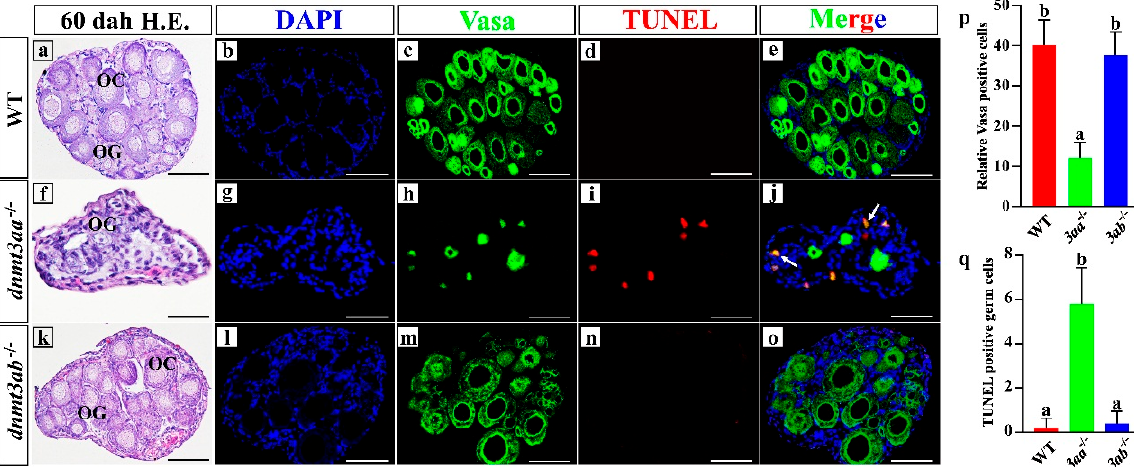
Figure 5. Apoptosis detection in WT, dnmt3aa − / − and dnmt3ab − / − ovaries at 60 dah. Increased apoptosis of germ cells in the ovaries of dnmt3aa − / − fish at 60 dah. ( a , f , k ) Histological analyses of germ cells by H&E staining. ( b , g , l ) Nuclei were coun- terstained with DAPI. ( c , h , m ) Green fluorescence represents the Vasa signals. ( d , i , n ) Red fluorescence represents the TUNEL-positive signals. ( e , j , o ) Co-localization of some Vasa and TUNEL signals as indicated by orange color in Nile tilapia ovaries. ( p ) Germ cell count of WT, dnmt3aa − / − and dnmt3ab − / − ovaries at 60 dah. ( q ) TUNEL-positive germ cells in the median section of the ovaries (part2) ( n = 5 for each genotype). Results are presented as mean ± SD. Different letters above the error bar indicate statistical differences at p < 0.05 as determined by one-way ANOVA followed by Tukey’s post hoc test. dah, days after hatching. Scale bar, 10 μ m.